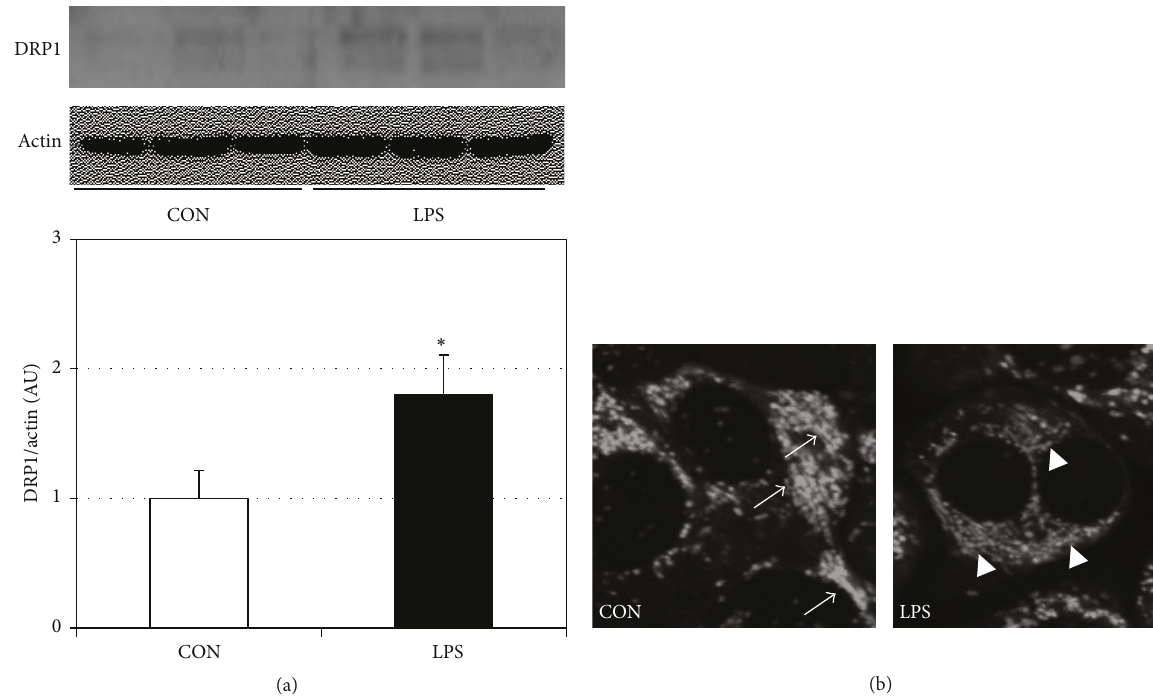
Figure 5: LPS increases mitochondrial fission in HGF-1 cells. Following LPS treatment (5 𝜇 g/mL for 48 h), cells were either harvested to determine DRP1 levels via western blot ((a), 𝑛 = 4 ) or visualized via confocal microscopy ((b); white arrows indicate sections of fusion; white arrowheads indicate fission; 𝑛 = 3 ). ∗ 𝑃 < 0.05 for CON versus